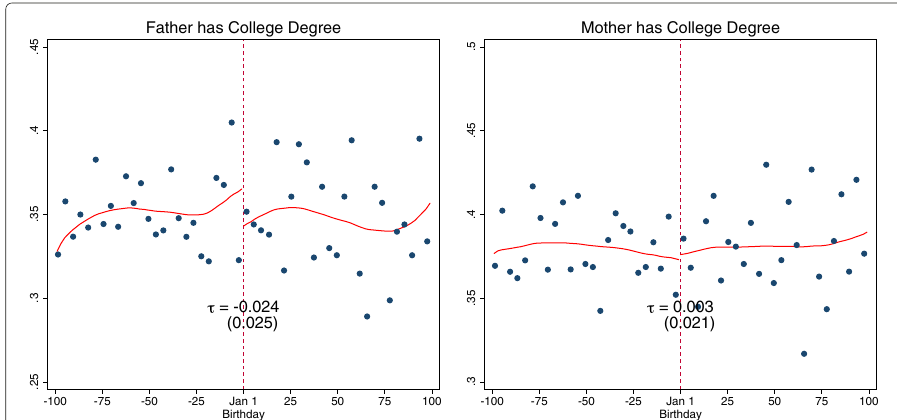
Fig. 3 Relationship between birthday and parents’ education. This figure shows the relationship between candidates’ birthday and their parents having a college degree. The center of the graphs is zero, which represents January 1. The first graph on the left shows the probability of the father having a college degree. The second graph on the right shows the probability of the mother having a college degree. Functions are estimated using a triangular kernel with the bandwidth selection procedure proposed by Calonico et al. (2014). τ is the RD estimate, with robust standard errors in parentheses